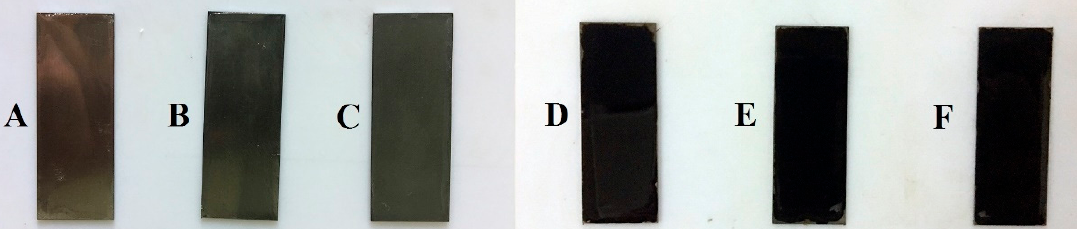
Figure 13. Digital photographs of benzoxazine coatings before and after curing reaction: ( A ) for poly (SIE-e); ( B ) for poly (SIE-b); ( C ) for poly (SIE-d); ( D ) for cured-poly (SIE-e); ( E ) for cured-poly (SIE-b); and ( F ) for cured-poly (SIE-d). Table 3. Coating performance of cured benzoxazine oligomers.